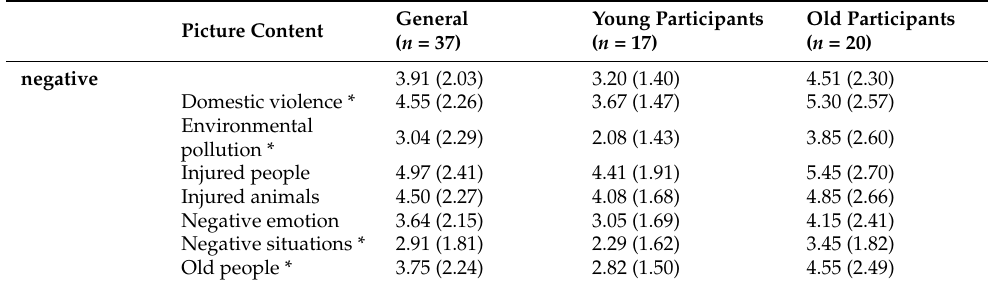
Table 6. Means (M) and standard deviations (SD) for the subjective ratings of picture type and picture content for each age group. * Represents a significant difference between age group and Picture